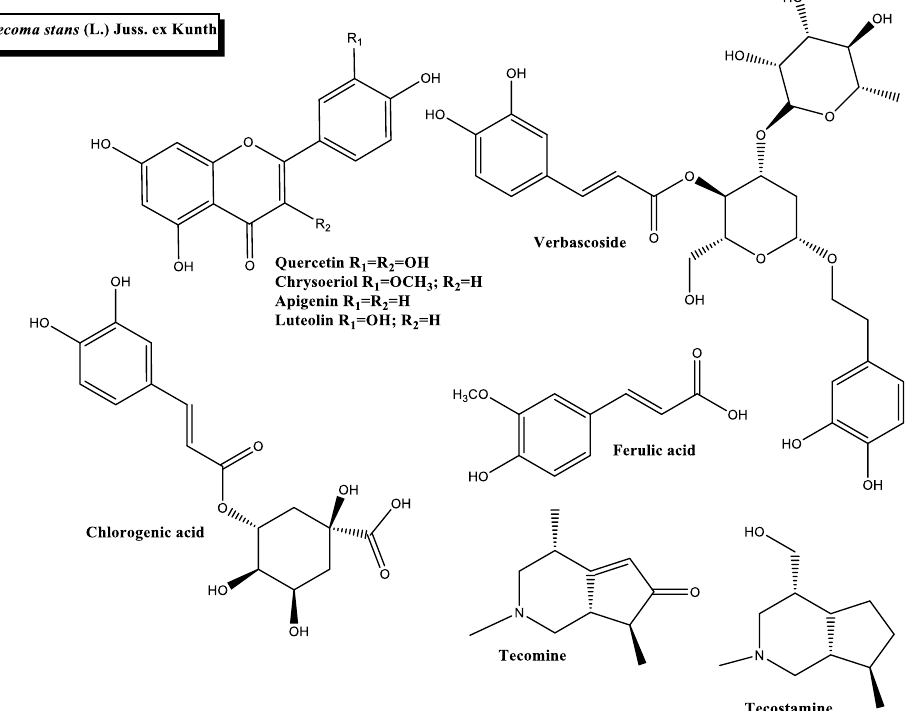
Figure 7. Chemical structures of bioactive phytocompounds with reported antidiabetic properties identified in Tecoma stans (L.) Juss. ex Kunth. Approximately 120 different compounds have been isolated from Tecoma stans